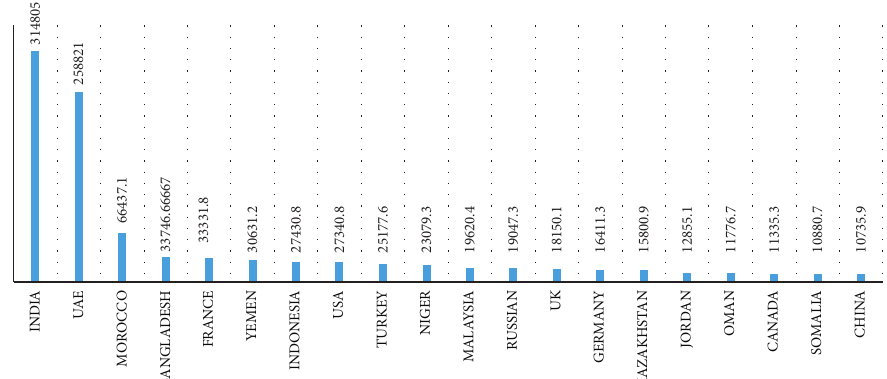
Figure 2: Dates global average import in tonnes by the highest importing countries of dates for the period of 2010–2019. The data extracted from the International Trade Centre database